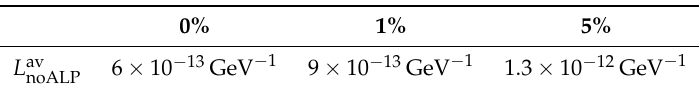
Table A1. Projected upper limits on g a γγ with IXPE using the likelihood ratio method. The columns correspond to different intrinsic polarisations of the